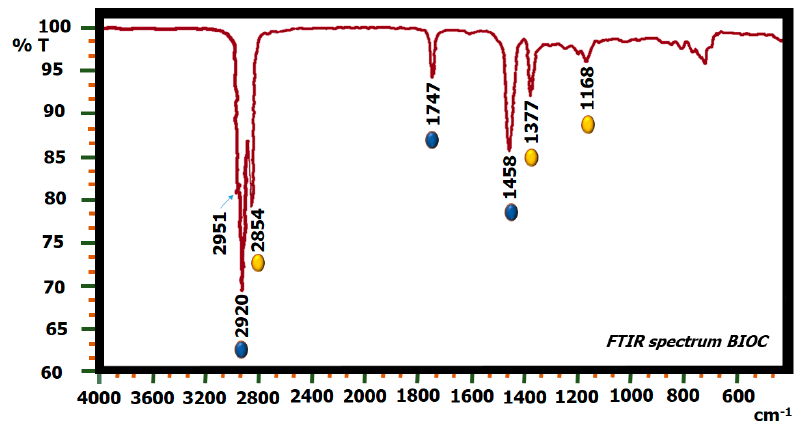
Figure 6. FTIR spectrum of BIOC.